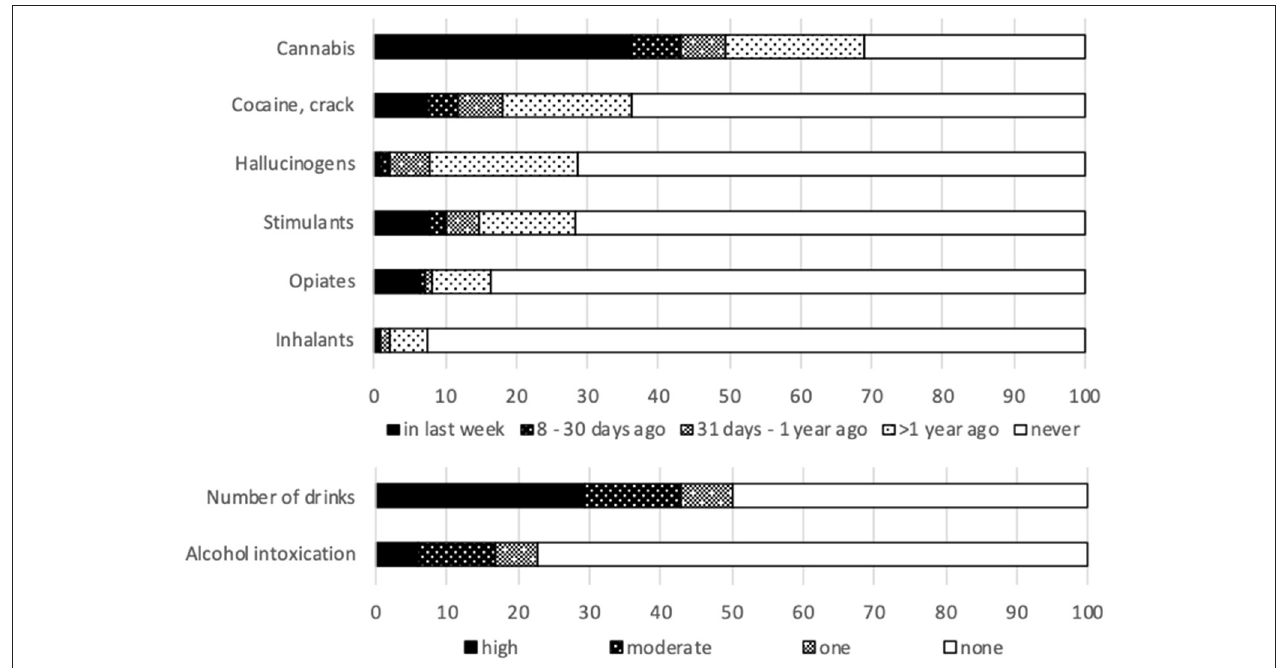
FIGURE 2 | Substance use frequency. Number of alcoholic drinks in the last fortnight: one; 2–4 (moderate); 5 or more (high). Number of days to point of intoxication in the last month: one; 2–8 (moderate); 9 times or more (high).